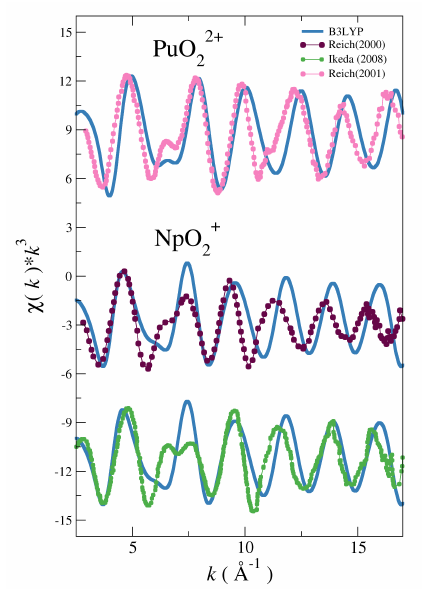
Figure 3. Simulated (blue solid line) and experimental (dots) L III -edge k 3 -weighted EXAFS spectra for PuO 2+ and NpO + in water. The experimental EXAFS are taken from Reich (2001) [33] (pink dotted line) 2 2 for plutonyl, and from Reich (2000) [31] (magenta dotted line) and Ikeda (2008) [32] (green dotted